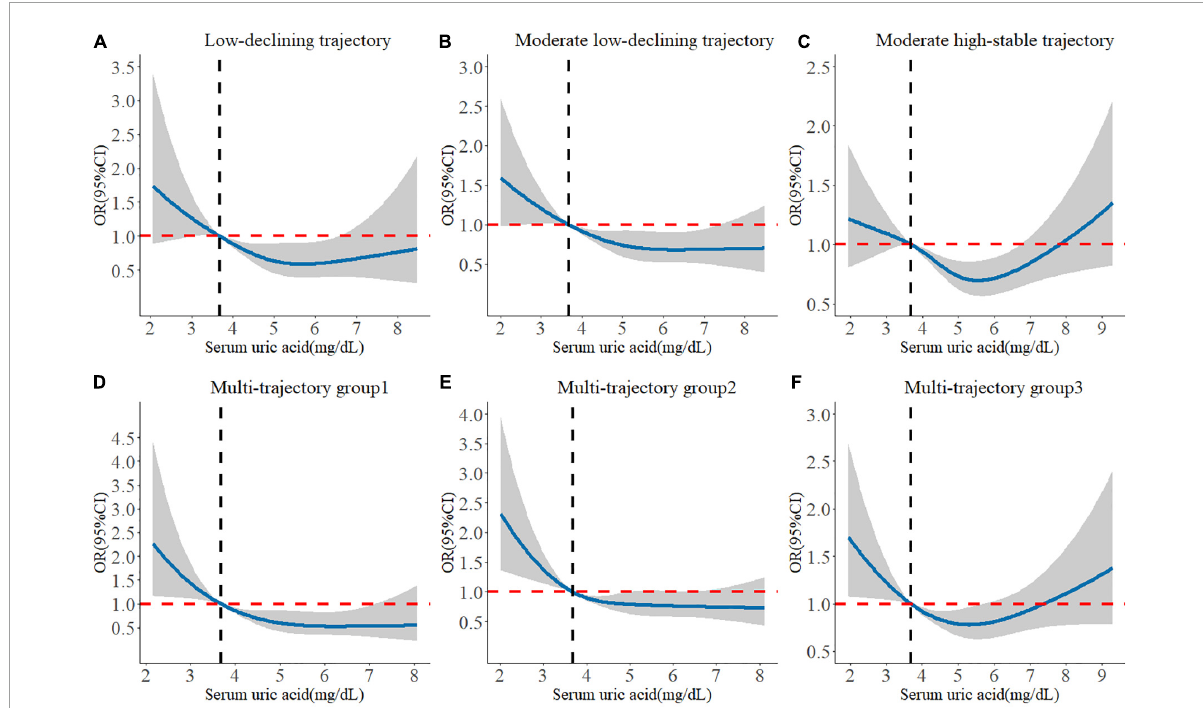
FIGURE2 Longitudinal dose-response relationship between baseline SUA levels and poorer cognitive trajectories. The curve was estimated by a restricted cubic spline function with four knots. Solid lines indicate OR. The reference was set to 3.686 mg/dL (25th quantile). The shadow represents 95% confidence intervals. (A) Longitudinal dose–response relationship between baseline SUA levels and low-declining global cognitive trajectory. (B) Longitudinal dose–response relationship between baseline SUA levels and moderate low-declining global cognitive trajectory. (C) Longitudinal dose–response relationship between baseline SUA levels and moderate high-stable global cognitive trajectory. (D) Longitudinal dose–response relationship between baseline SUA levels and “episodic memory: low-rapid declining + executive function: low-declining” trajectory. (E) Longitudinal dose–response relationship between baseline SUA levels and “episodic memory: low-minimal declining + executive function: moderate-declining” trajectory. (F) Longitudinal dose–response relationship between baseline SUA levels and “episodic memory: moderate-stable + executive function: high-declining”